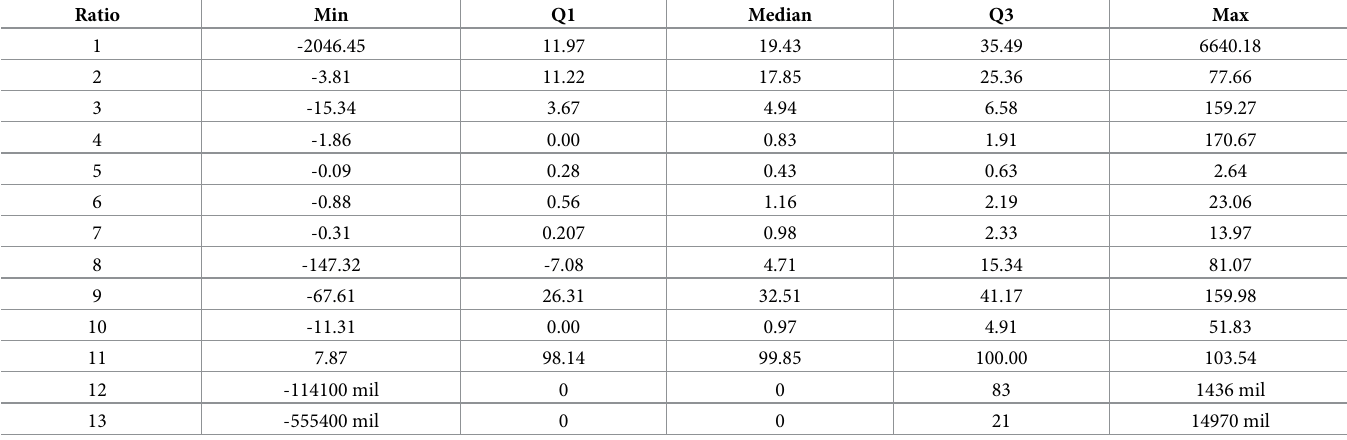
Table 1. Five number summary of the 13 financial ratios. Note that mil represents million. Q1 and Q3 are the lower and upper quartiles. More information can be found in Mongwe and Malan